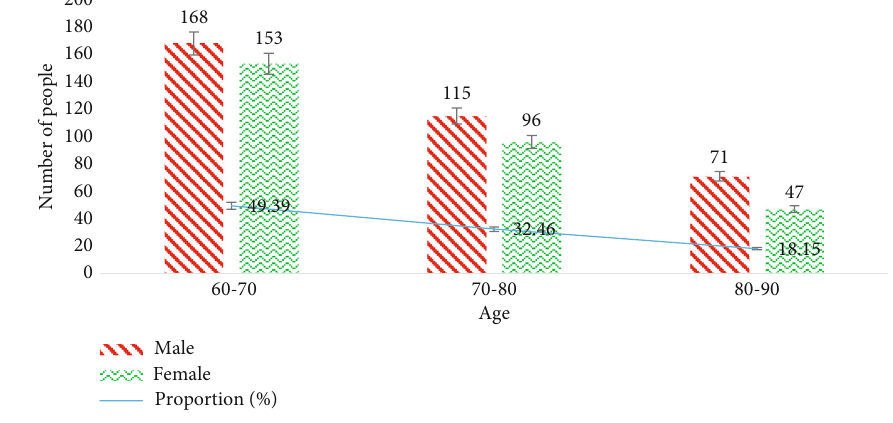
Figure 2: Number of patients by age and gender. Table 2: Living conditions and distribution of